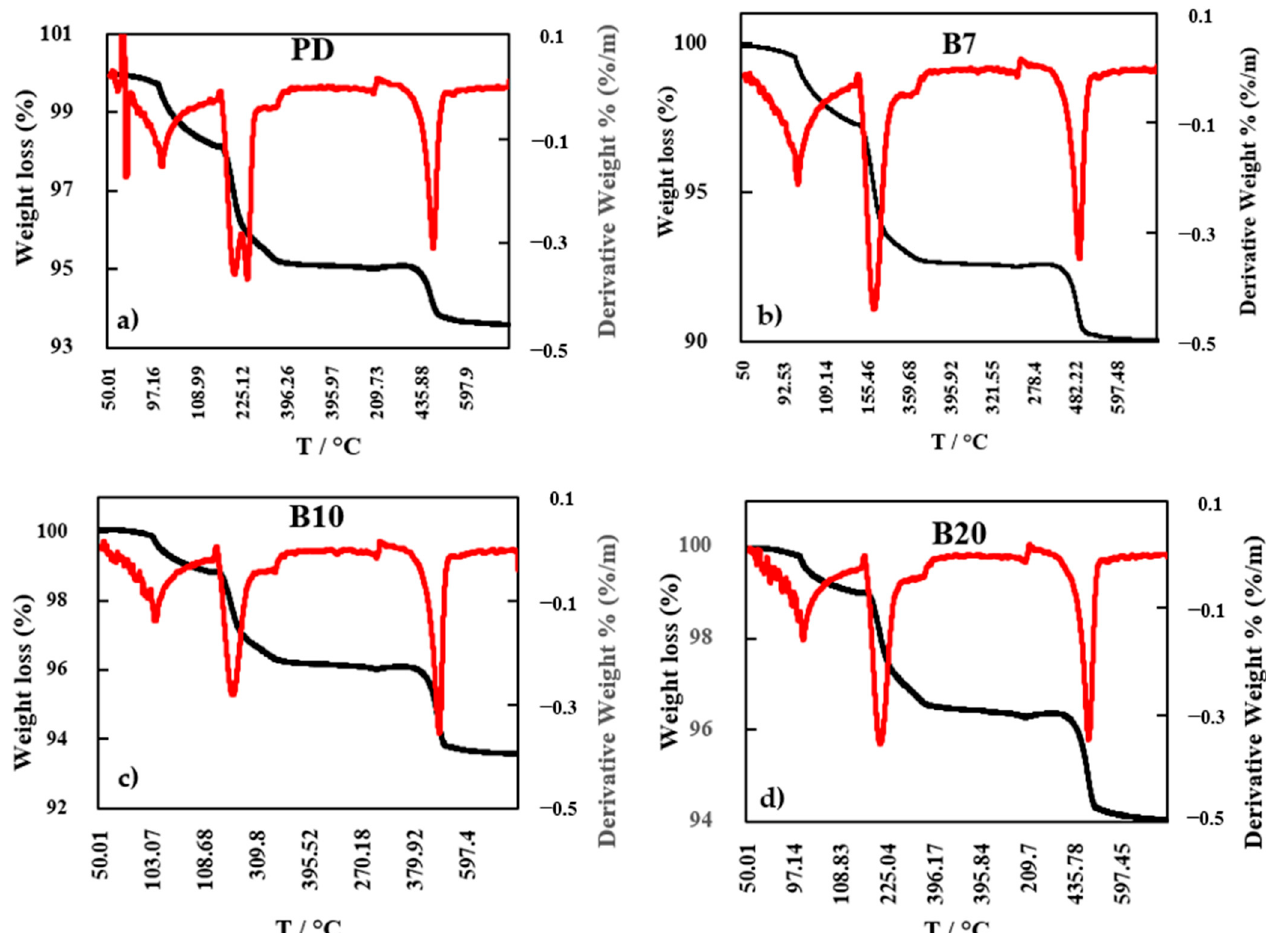
Figure 9. TGA spectra for the NTP of soot, before and after: all fuel_2000_IMEP 6 bar.